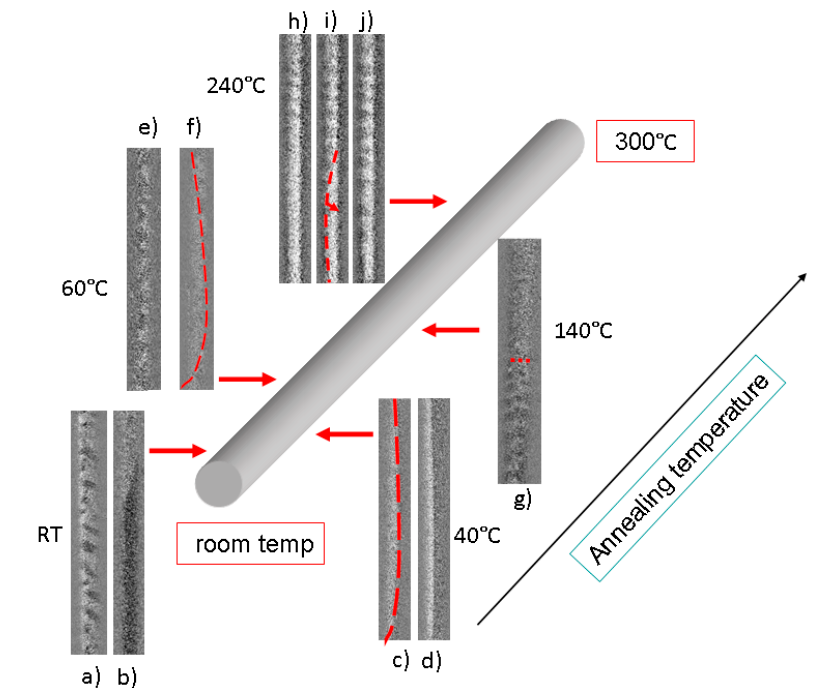
Figure 5. Distribution of surface domain structure along the sample length. ( a ) multi-domain structure, ( b ) inclined elliptic domain wall, ( c ) long curved domain wall, ( d ) longitudinally oriented domain wall, ( e ) multi-domain structure, ( f ) curved domain wall, ( g ) combination of two types of domain structure, ( h – j ) consistent motion of inclined spiral domains. Red dashed lines show the positions of the fronts separating the different types of domains.